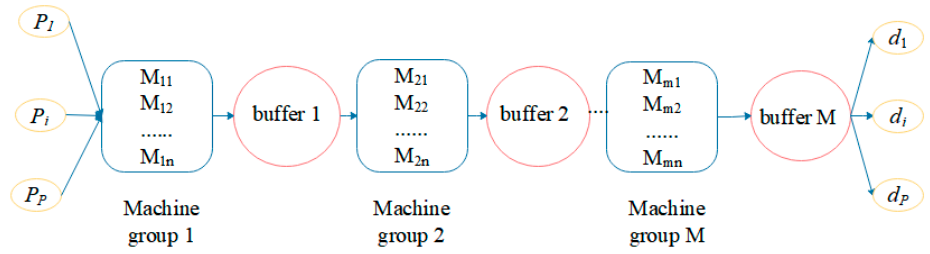
Figure 1. The production model of the multiple machines and multiple product types manufacturing system.